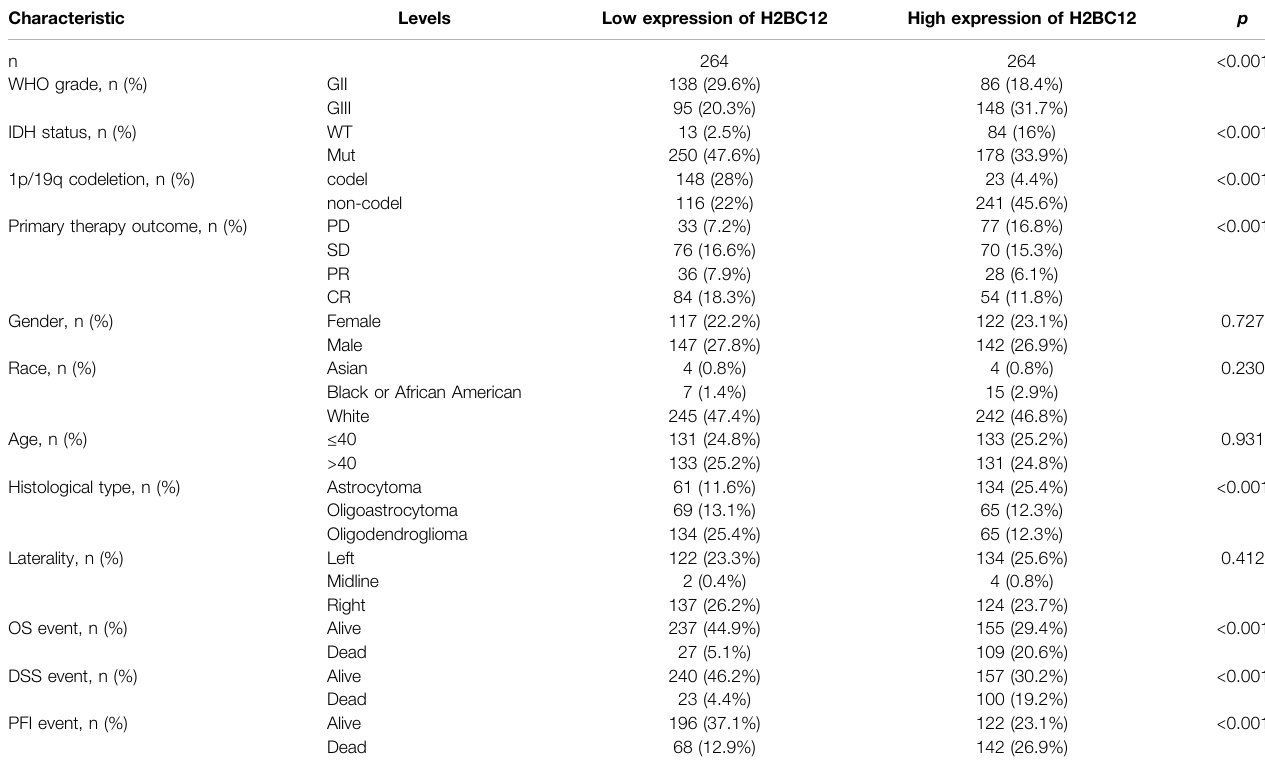
TABLE 2 | Relationship between H2BC12 mRNA expression and clinical characteristics in gliomas.